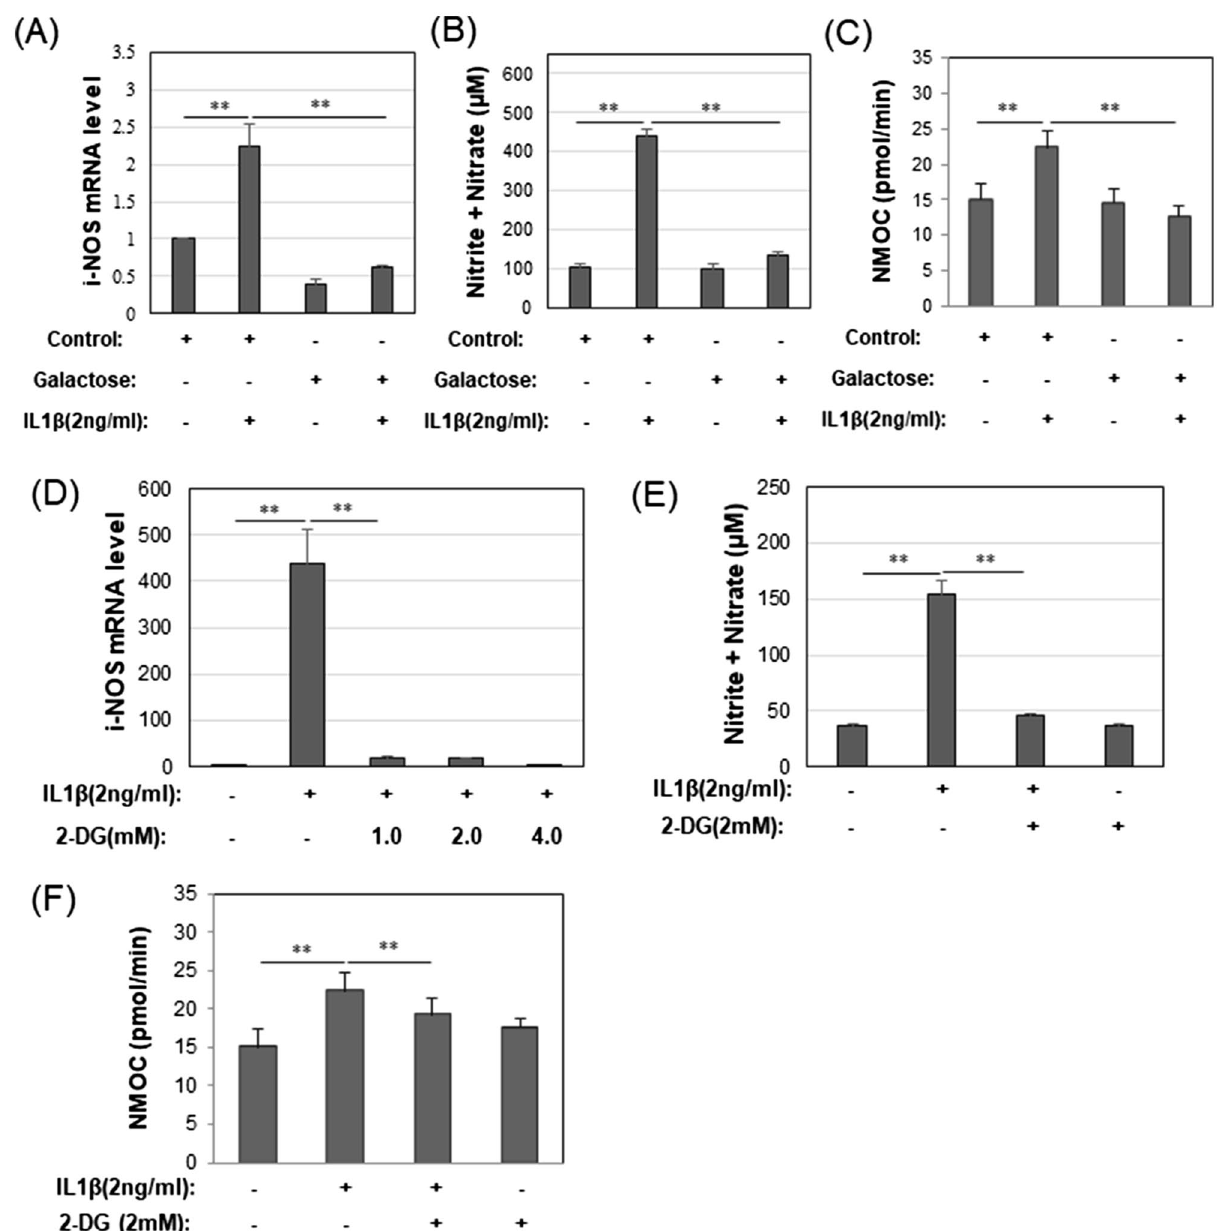
Figure 5. Galactose blocks the end products of NO and NMOC markers of mitochondrial damage. ( A ) The mRNA of inducible nitric oxide synthase (iNOS) was measured by RT-Real Time PCR for chondrocytes in Control glucose or galactose culture condition treated with or without IL1β [mean ± S.D. (error bars), n = 3]. ( B ) Total amount of Nitrite and Nitrate in cell culture medium was determined for chondrocytes in Control glucose or galactose culture condition treated with or without IL1β [mean ± S.D. (error bars), n = 3]. ( C ) Non mitochondrial Oxygen Consumption Rate (OCR) by chondrocytes treated with or without IL1β in Control glucose or galactose cultures as labeled [mean ± S.D. (error bars), n = 8]. ( D ) mRNA levels of inducible nitric oxide synthase (iNOS) were measured by qRT-Real Time PCR for chondrocytes in Control glucose conditions treated with or without IL1β and 2DG [mean ± S.D. (error bars), n = 3]. ( E ) NO (total amount of Nitrite and Nitrate) in cell culture medium was determined for chondrocytes in Control glucose culture conditions treated with or without IL1β and 2DG [mean ± S.D. (error bars), n = 3]. ( F ) Non mitochondrial Oxygen Consumption Rate (OCR) by chondrocytes treated with or without IL1β and 2DG in Control Glucose cultures as labeled [mean ± S.D. (error bars), n = 8]. ANOVA followed by Tukey post-hoc test was used for statistical analysis. *p < 0.05; **p <